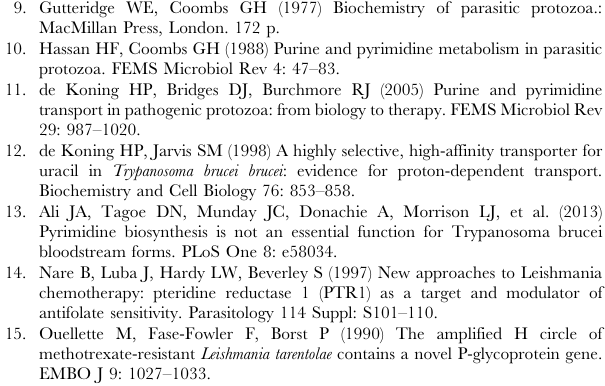
Figure S1 Sequence alignments of the active sites of thymidine kinase, uridine phosphorylase and uracil phosphoribosyl transferase. The regions of the active sites of the Leishmania TK, UP and UPRT were aligned with the Trypanosoma , mice and human homologues. The highlighted amino acid residues are those in which mutations were found. The highly conserved Q87 in the TK active site is mutated to a P in Lin5FU500.3. Position of the L265R mutation close to the specificity region in the UP enzyme in Lin5FU500.5 mutant. Position of the K145T mutation close to the phosphoribosyl pyrophosphate (PRPP) region in UPRT in Lin5FU500.4. (TIF) Table S1 Primers used in this study. Primer names were given according to the nomenclature of TritrypDB database. Primers were used in PCR reactions either to confirm locus rearrangements or presence or absence of particular genes (PCR amplification); to amplify genes that will be further cloned in plasmids for transfection assays (Cloning); to generate probes for Southern blotting (Southern); or to confirm mutations (SNP validation). Restriction sites are underlined. XbaI, TCTAGA; HindIII, AAGCTT; F, forward primer; R, reverse primer. The size of amplicons is indicated in base pairs